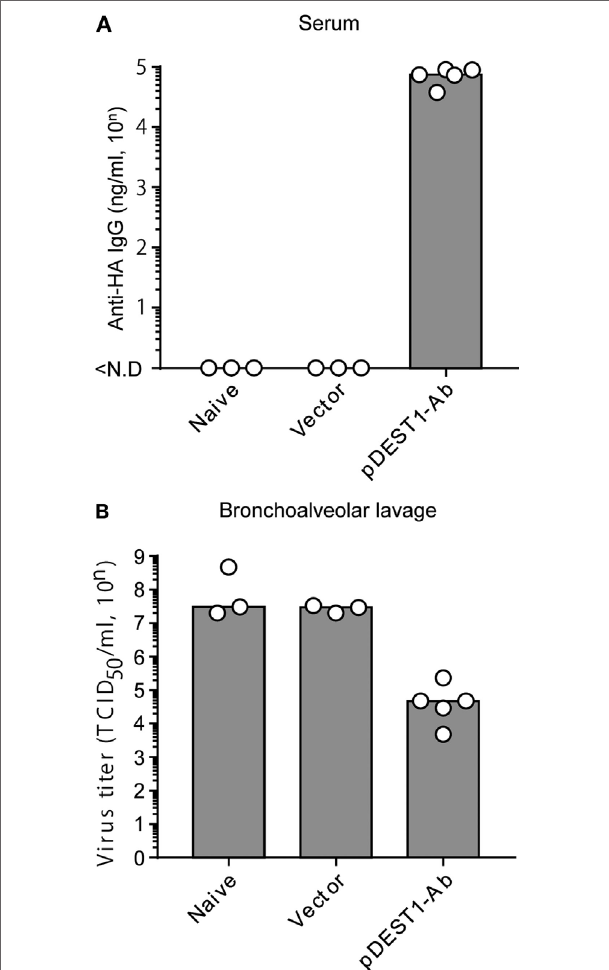
FigUre 2 | HD reduced virus titer in the bronchoalveolar lavage. (a,B) HD for anti-HA IgG was performed in BALB/c mice 1 day post-infection with a lethal dose of A/PR8 virus (1,000 TCID 50 ). Three days post-infection, serum and bronchoalveolar lavage specimens were obtained from the infected mice. (a) Neutralizing monoclonal antibody (mAb) levels in the serum were measured by quantitative ELISA. ND, not detected. (B) Viral titers in the bronchoalveolar lavage specimens were determined by a micro-titer assay, as an index of protection against infection. Data were analyzed using a non-parametric Kruskal–Wallis test ( p = 0.02204). Each bar represents the median. The indicated data are representative two independent